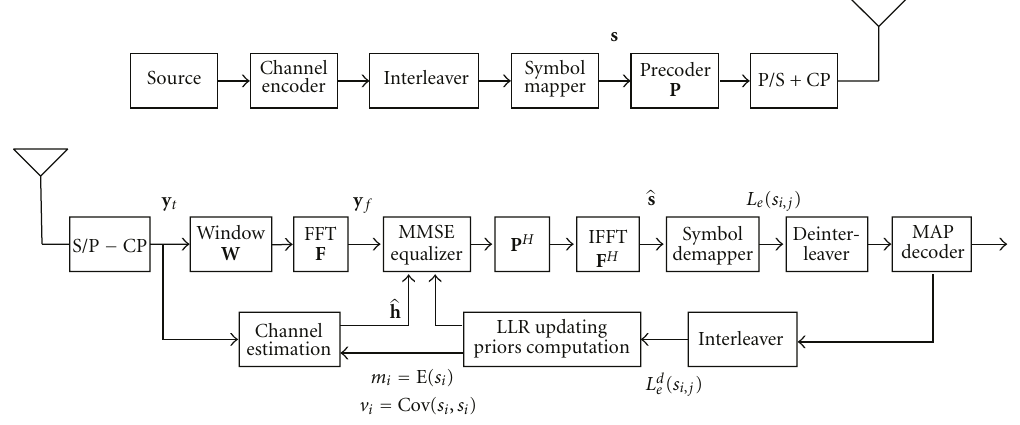
Figure 1: System